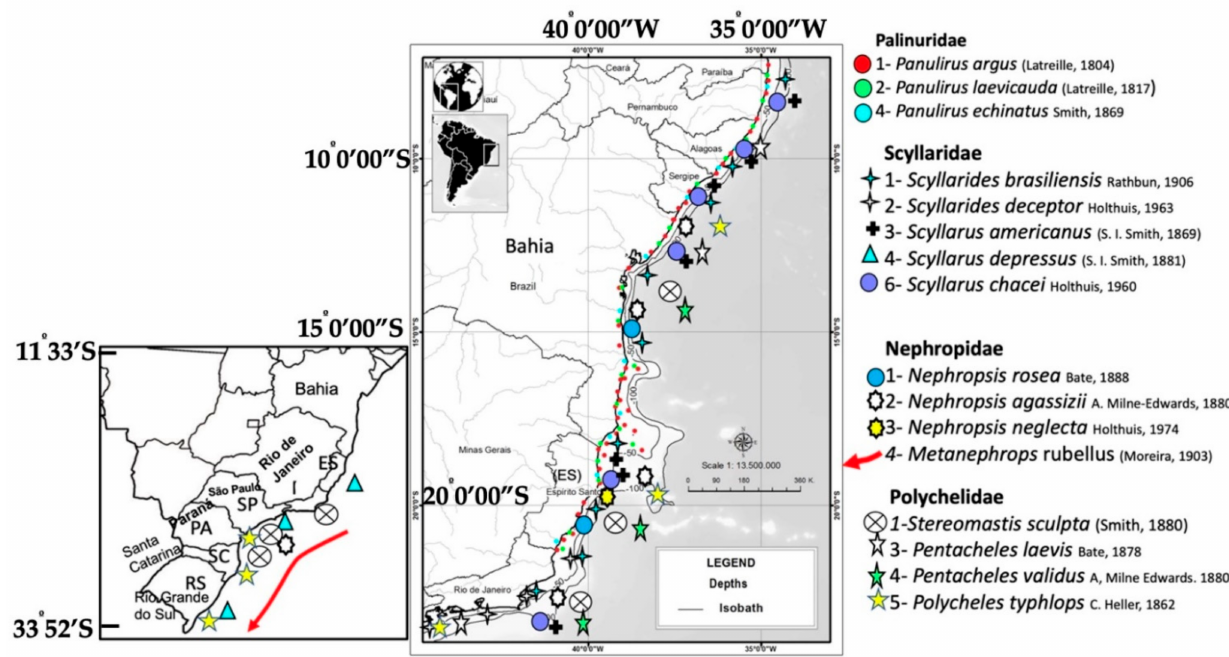
Figure 3. Spatial distribution and diversity of lobsters in southeastern (SE) and southern (S) sections of continental shelf of Brazil